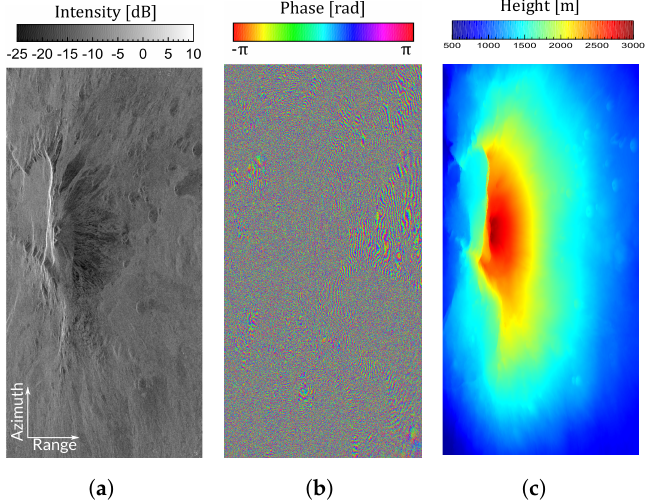
Figure 10. Master image intensity, original interferogram, and DEM height of the processed area (converted to slant − range coordinates). ( a ) Master intensity (dB). ( b ) Interferogram. ( c ) DEM height of the processed area.